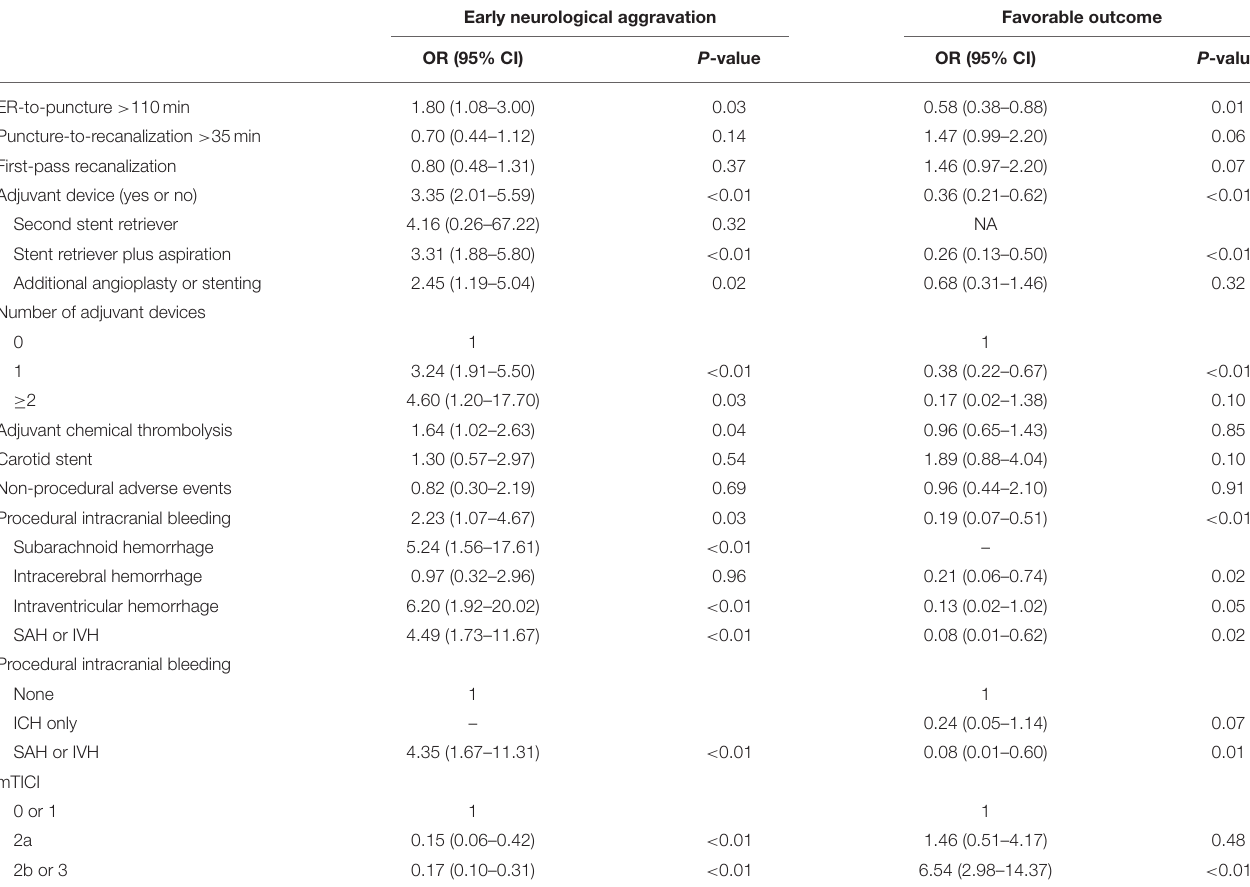
TABLE 2 | The association of each predictor with early neurological aggravation and the favorable